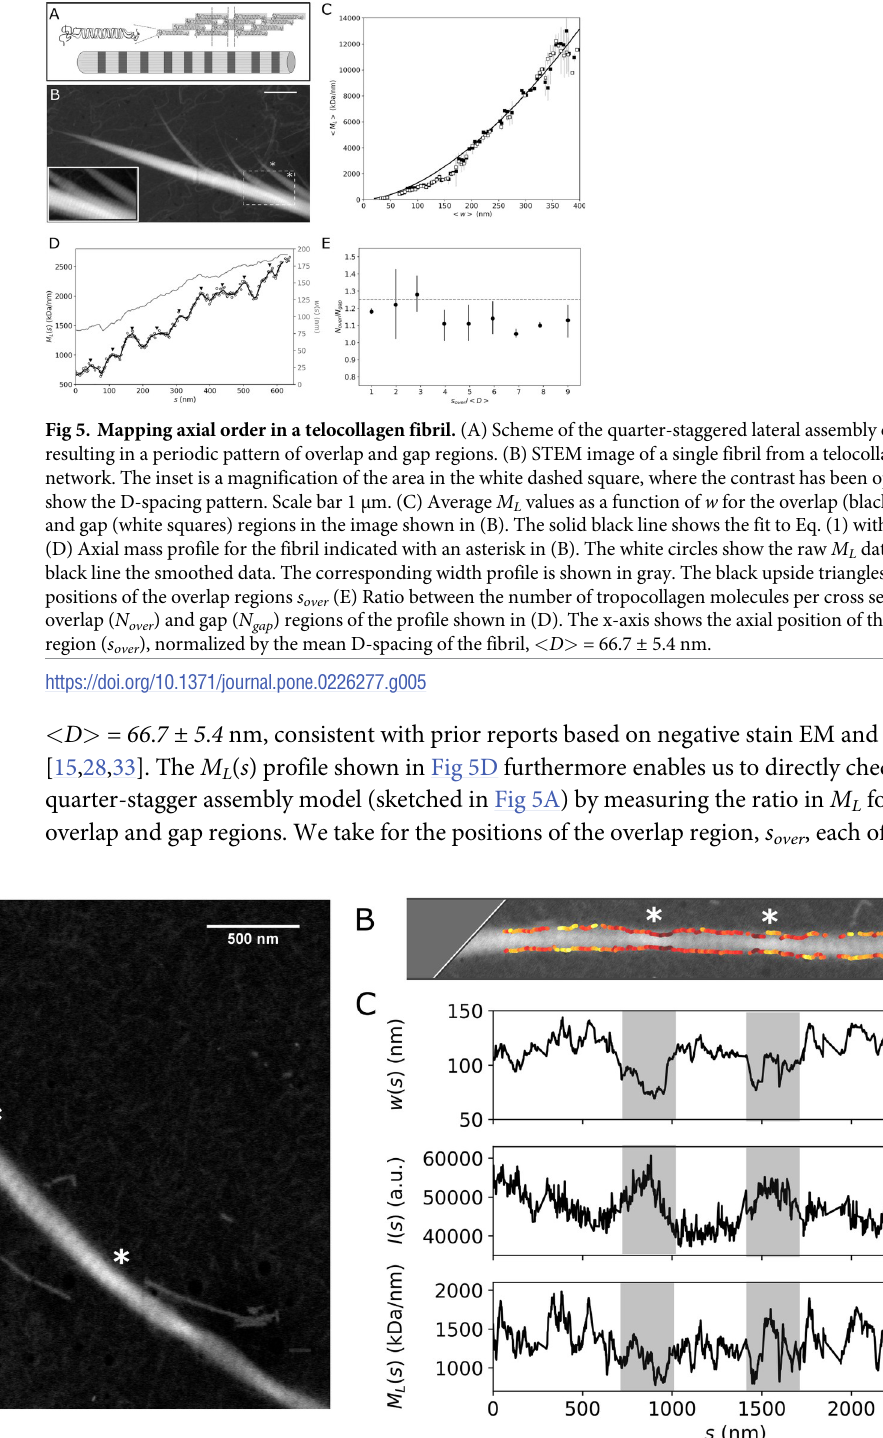
color coded in the same range shown in (C). (C) Axial profiles for fibril M L (s)